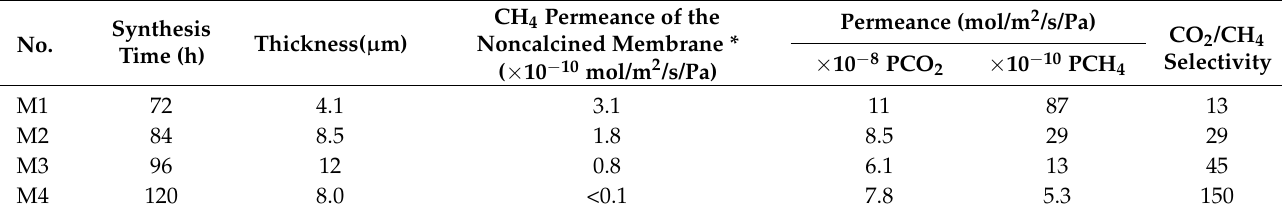
Table 2. Equimolar CO 2 /CH 4 mixture separation performances of Al-containing ZSM-58 zeolite membranes with different synthesis times at a total feed pressure of 1.1 MPa and at room temperature.